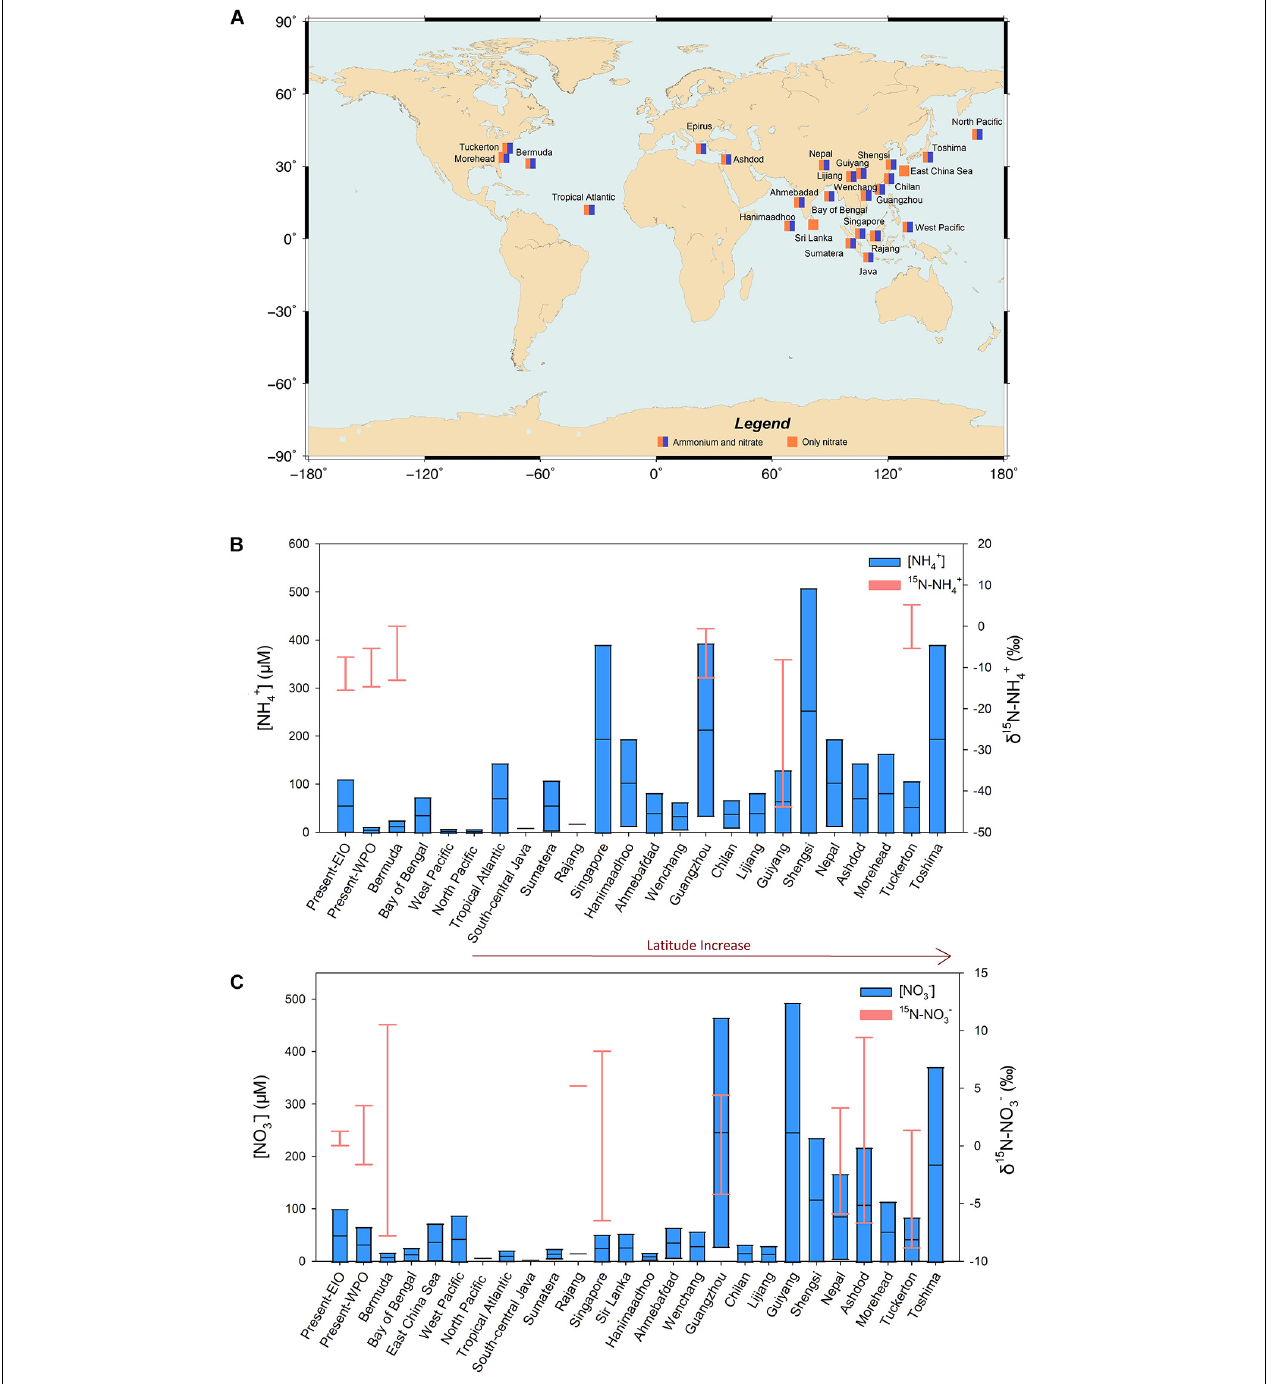
FIGURE 6 | Global comparison of NO 3 - /NH 4 + concentrations and isotopes among different study sites ( A : location, B : NH 4 + comparison, C : NO 3 − comparison; detailed references in Supplementary Table S2 ). The majority of them are around the EIO and WPO. Notably, the NO 3 - /NH 4 + concentration range in the EIO excludes the value obtained from